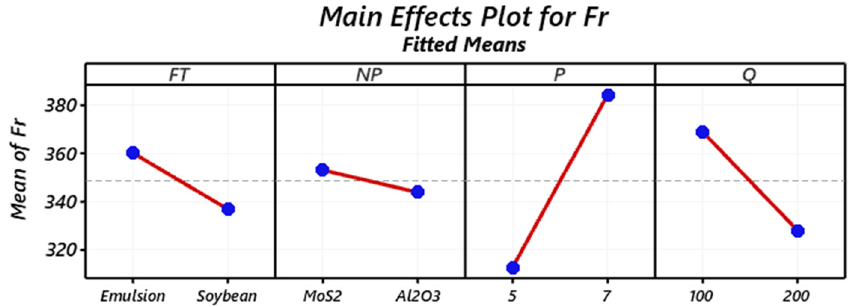
Figure 9. Main effects plot of input machining factors on the resultant cutting force F r .